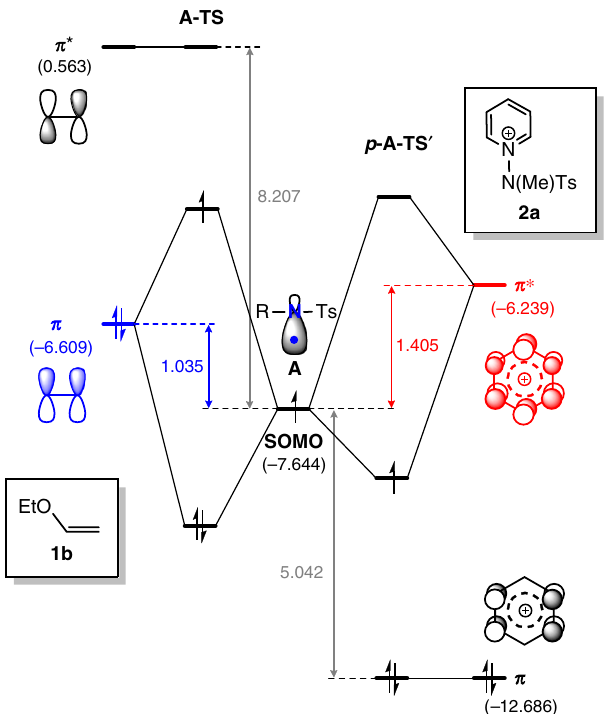
Fig. 3 MO diagram. Qualitative MO diagram of N-centered radical interaction with the enolether 1b or the pyridinium salt 2a . Energies are given in